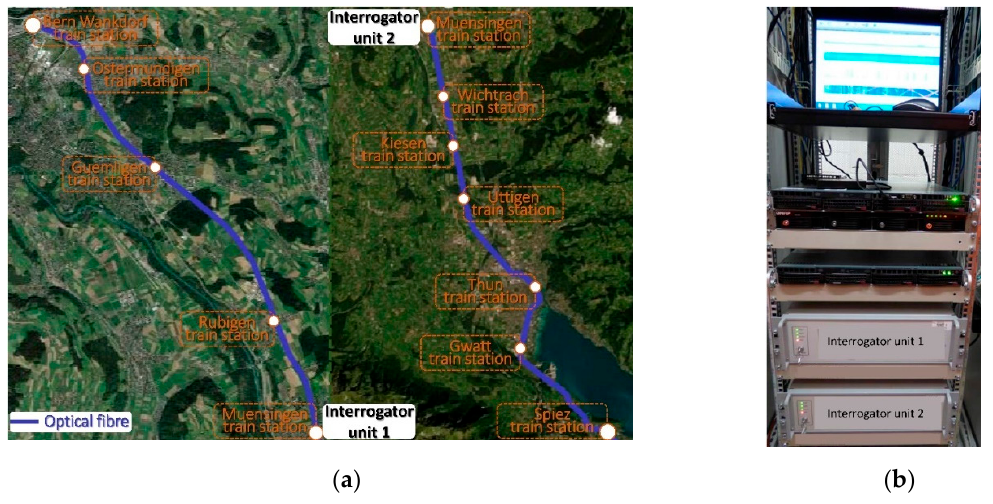
Figure 2. ( a ) Schematic track and fibre layout of the monitored route between Bern Wankdorf and Spiez, located in Switzerland; ( b ) rack mounted interrogator units located in the telecommunications room in Muensingen side ‐ by ‐ side with the processing unit at the top.